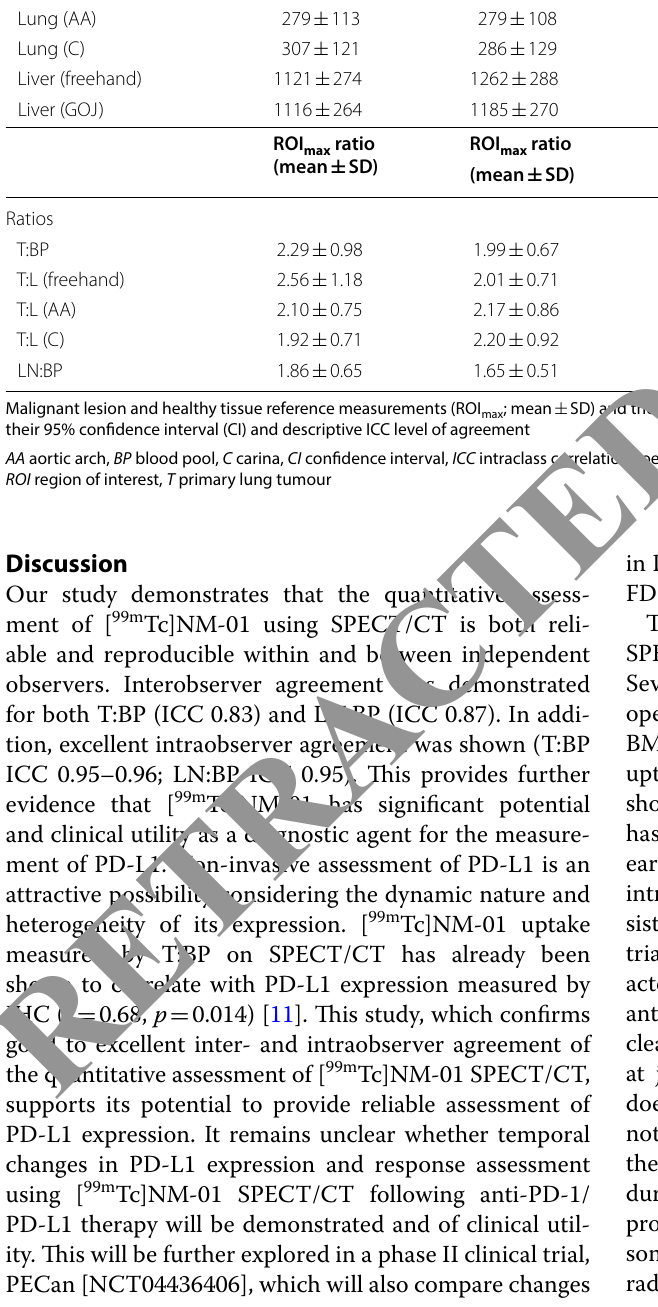
Table 2 Interobserver agreement